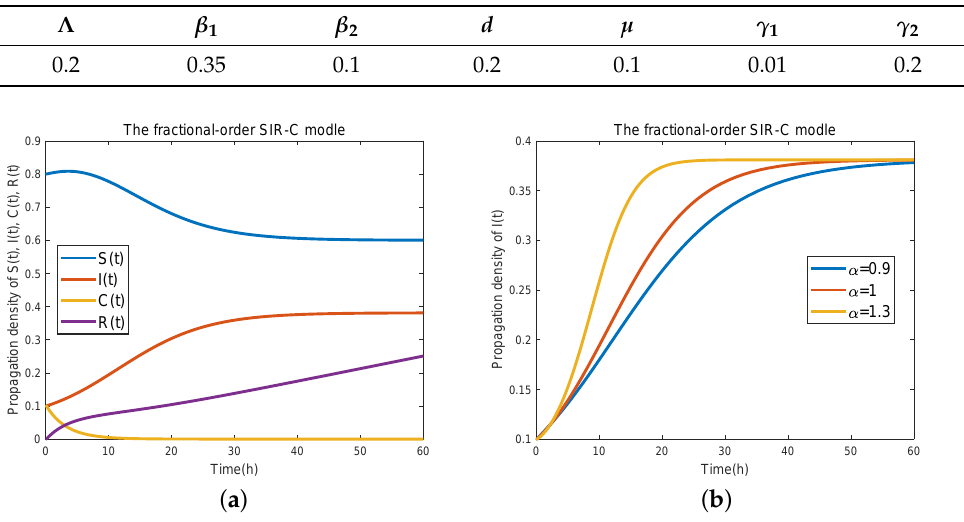
Table 4. Parameter for the global asymptotic stability of E 2 .